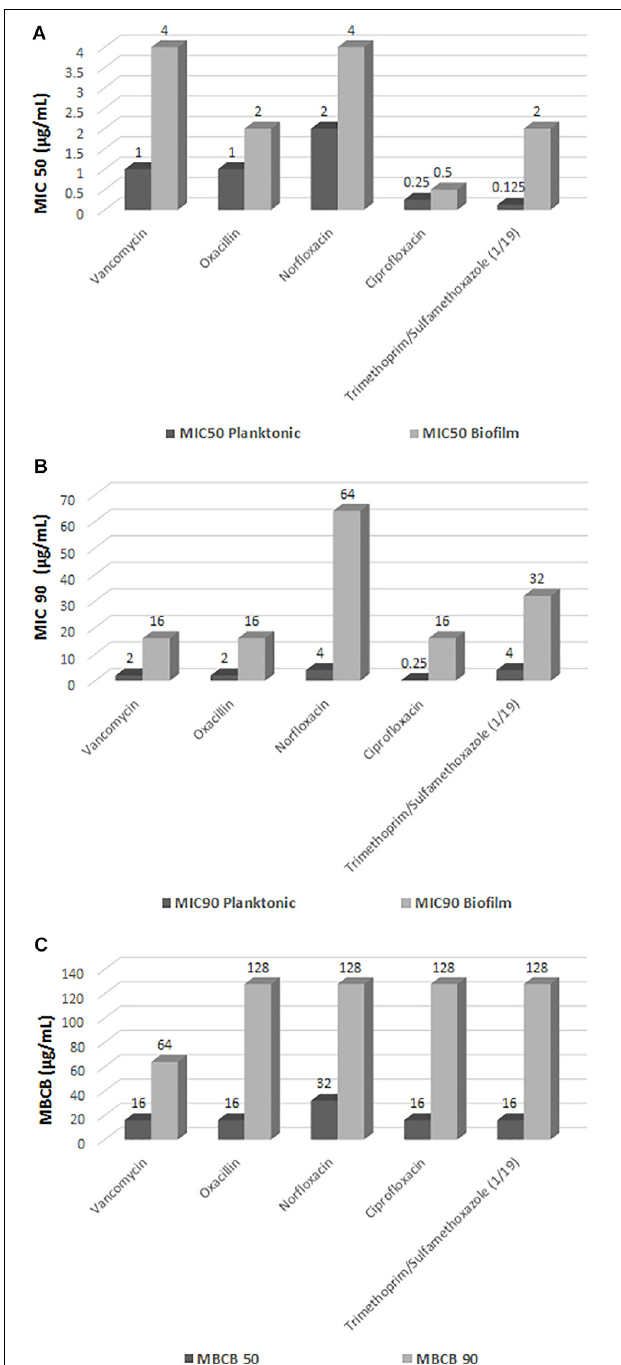
FIGURE 2 | Minimum inhibitory concentration (MIC) in planktonic cells of Staphylococcus saprophyticus , minimum inhibitory concentration in biofilm (MICB), and minimum bactericidal concentration in biofilm (MBCB). (A) MIC 50 ( µ g/mL); (B) MIC 90 ( µ g/mL); (C) MBCB.